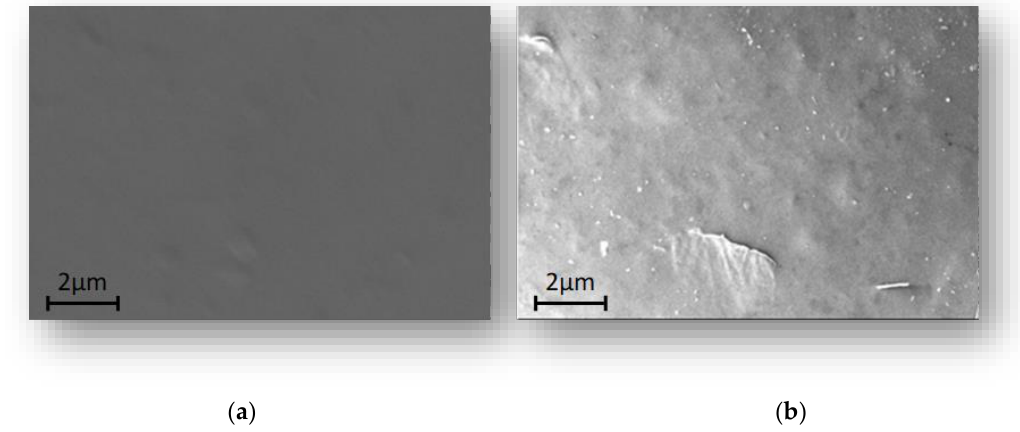
Figure 6. SEM photomicrographies of the membrane based on chitosan ( a ), and chitosan + CsACC ( b ). The images are taken at 10 K× magnification.